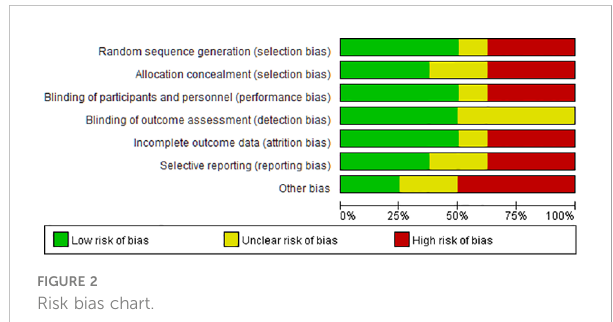
FIGURE 2 Risk bias